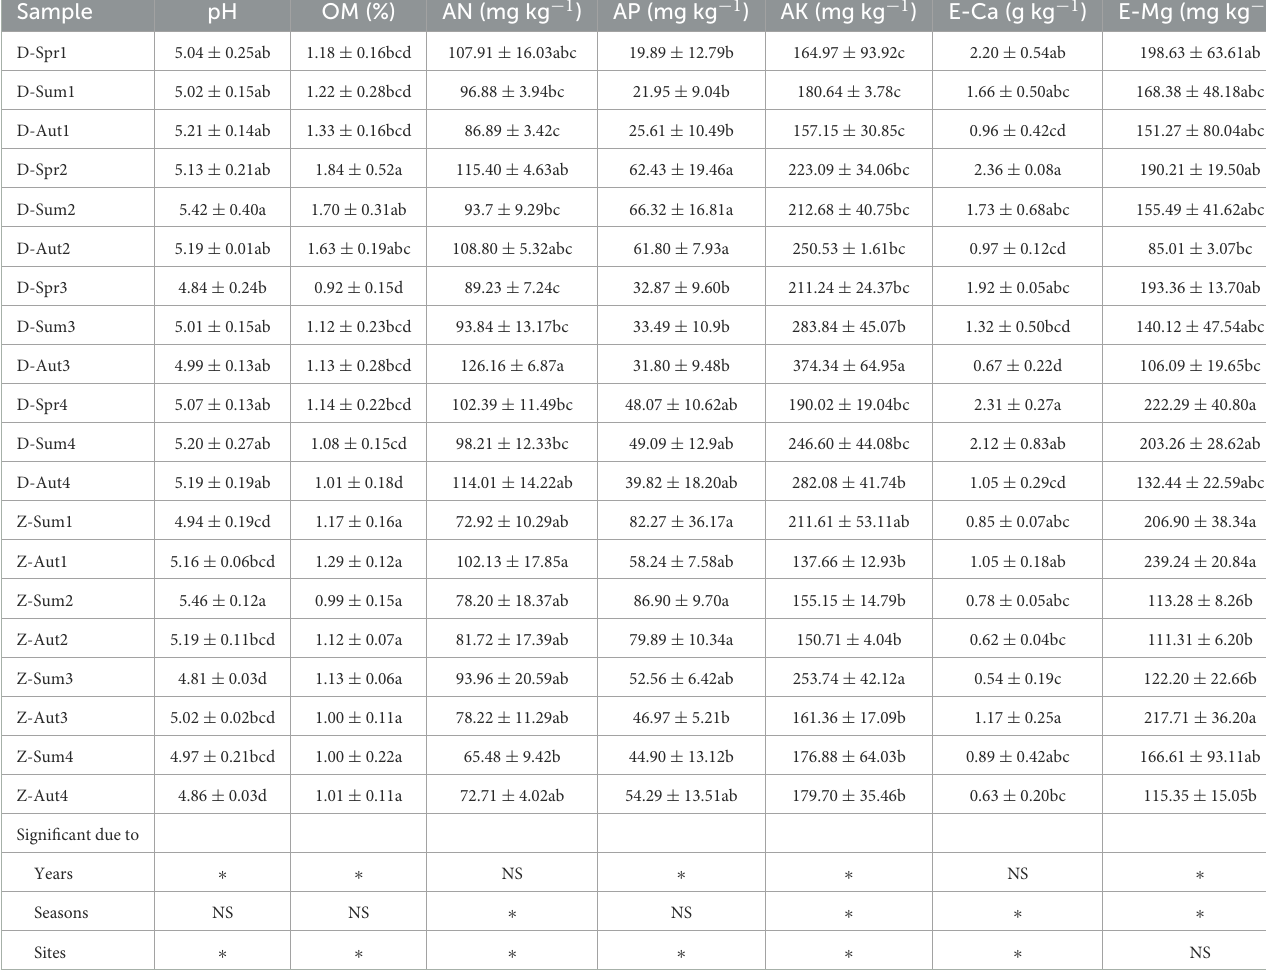
TABLE 3 Soil chemical properties at two sampling sites of different ginseng ages.